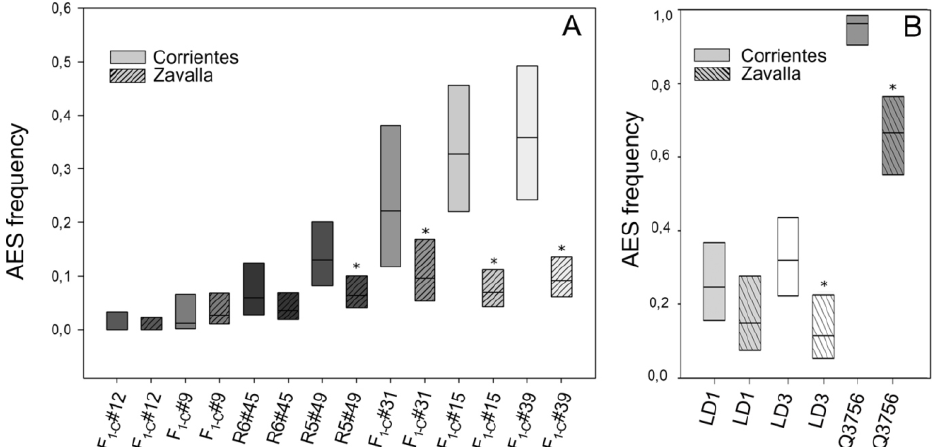
Figure 2. Apospory expressivity in P. rufum ( A ) diploid genotypes and ( B ) tetraploid individuals, assessed at the two locations. The frequency of ovaries containing AES (box middle line) scored in each plant is plotted together with 95% confidence intervals (CI). Boxes colored with different shades of grey indicate different genotypes; plain boxes represent measurements made in Corrientes, while striped boxes represent measurements made in Zavalla. Asterisks mark significant differences of the same genotype between different locations.